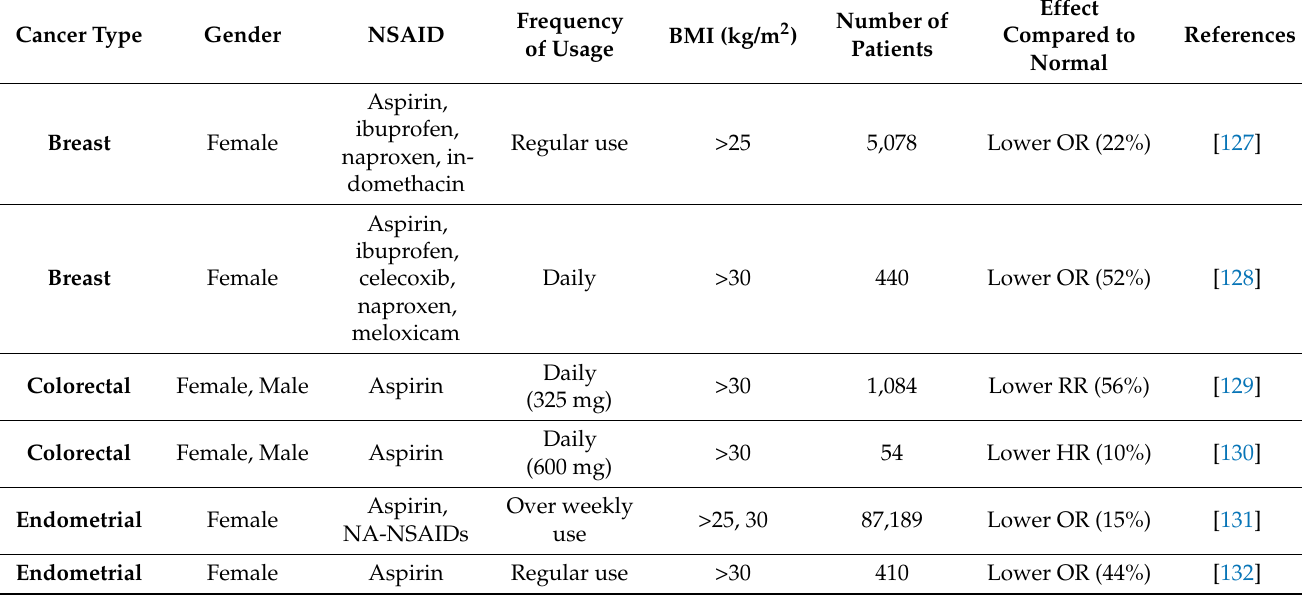
Table 1. The clinical results of NSAID use in obese patients with cancer Obesity-related cancers: esophageal, gallbladder, colorectal, pancreatic, postmenopausal breast, endometrial, kidney, and thyroid cancer. Abbreviations: NSAID, nonsteroidal anti-inflammatory drug; NA-NSAIDs; non- aspirin-NSAIDs: celecoxib, diclofenac, etodolac, fenoprofen, flurbiprofen, ibuprofen, indomethacin, ketoprofen, ketorolac, meclofenamate, mefenamic acid, nabumetone, naproxen/naproxen sodium, rofecoxib, sulindac, and valdecoxib; BMI, body mass index; OR, odds ratio; HR, hazard ratio; RR, risk